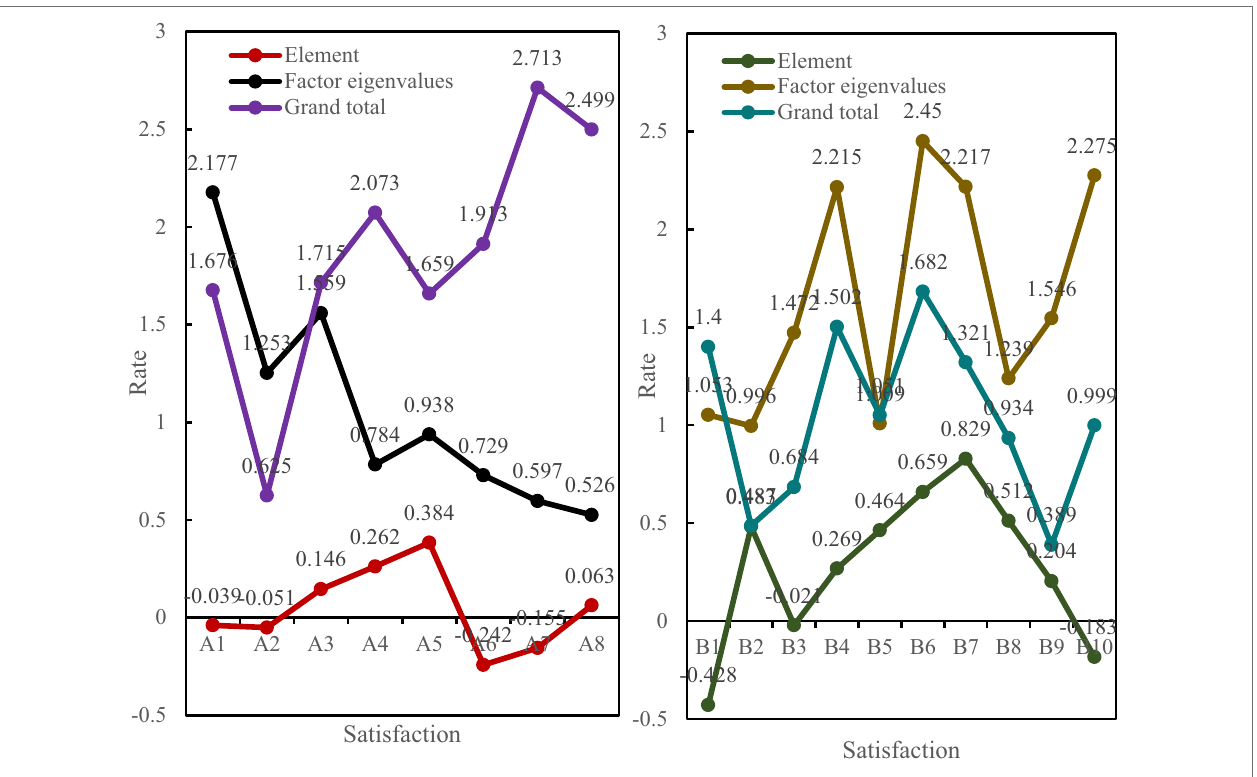
FIGURE 10 | Analysis of satisfaction factors of daily teaching psychology management and teaching security psychology management.